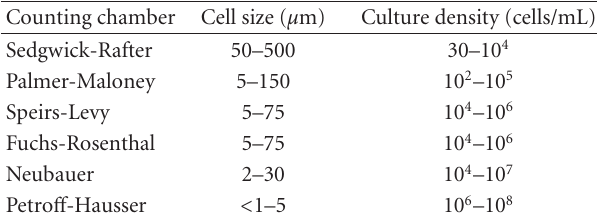
Table 1: Commercial cell-counting chambers